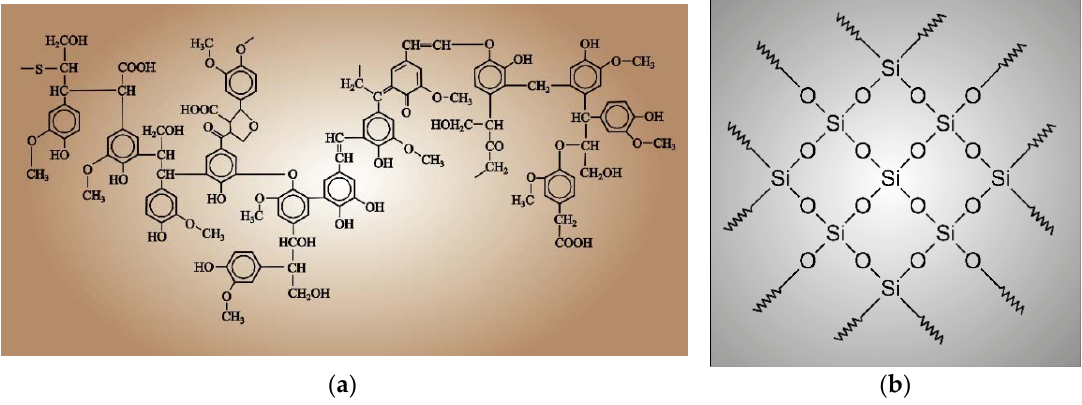
Figure 5. The structural formulas of ( a ) kraft lignin and ( b ) silica.